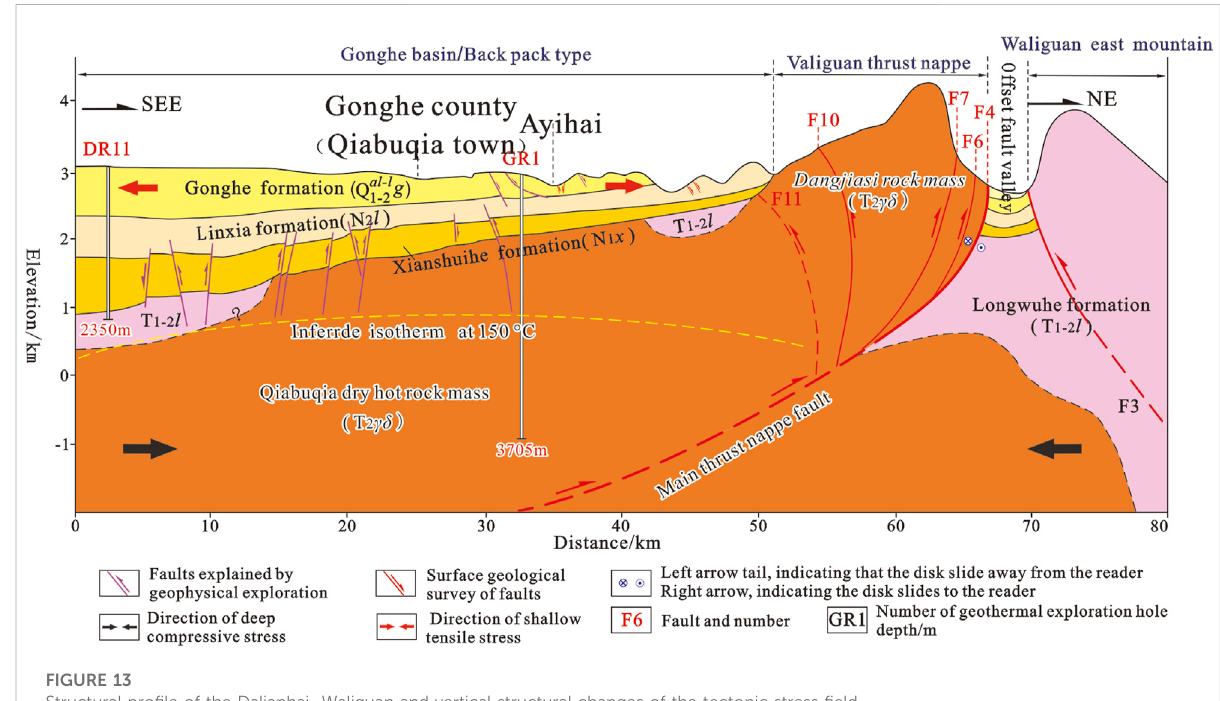
FIGURE 13 Structural pro fi le of the Dalianhai – Waliguan and vertical structural changes of the tectonic stress fi